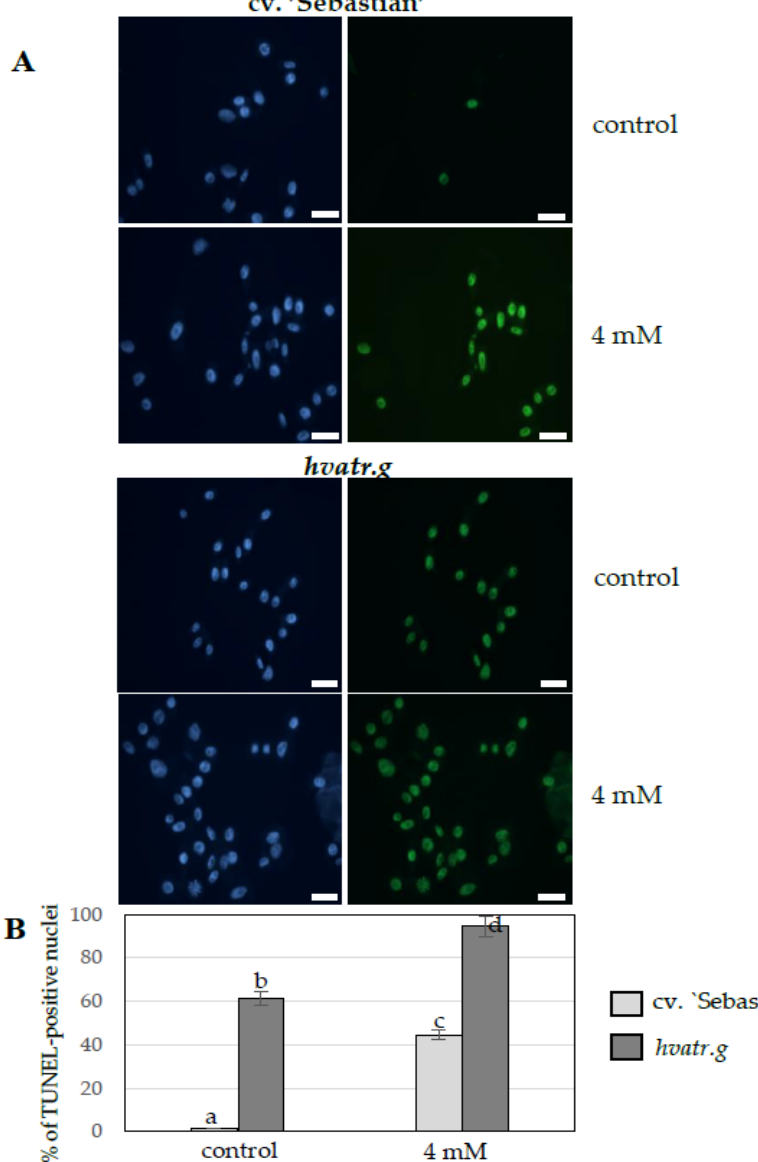
Figure 6. Results of TUNEL test in root cells of barley seedlings of the hvatr.g mutant and cv. “Sebastian”, control and MH-treated. ( A ) Examples of damaged nuclei observed in control “Sebastian” and hvatr.g roots and roots treated with 4 mM MH. Left images of DAPI-stained nuclei. Right images from the FITC channel. ( B ) Frequency of TUNEL-positive nuclei of root cells of barley seedlings of the hvatr.g mutant and cv. “Sebastian”, control and MH-treated. Statistical analyses were performed using ANOVA ( p < 0.05) followed by Tukey’s honestly significant difference test (Tukey